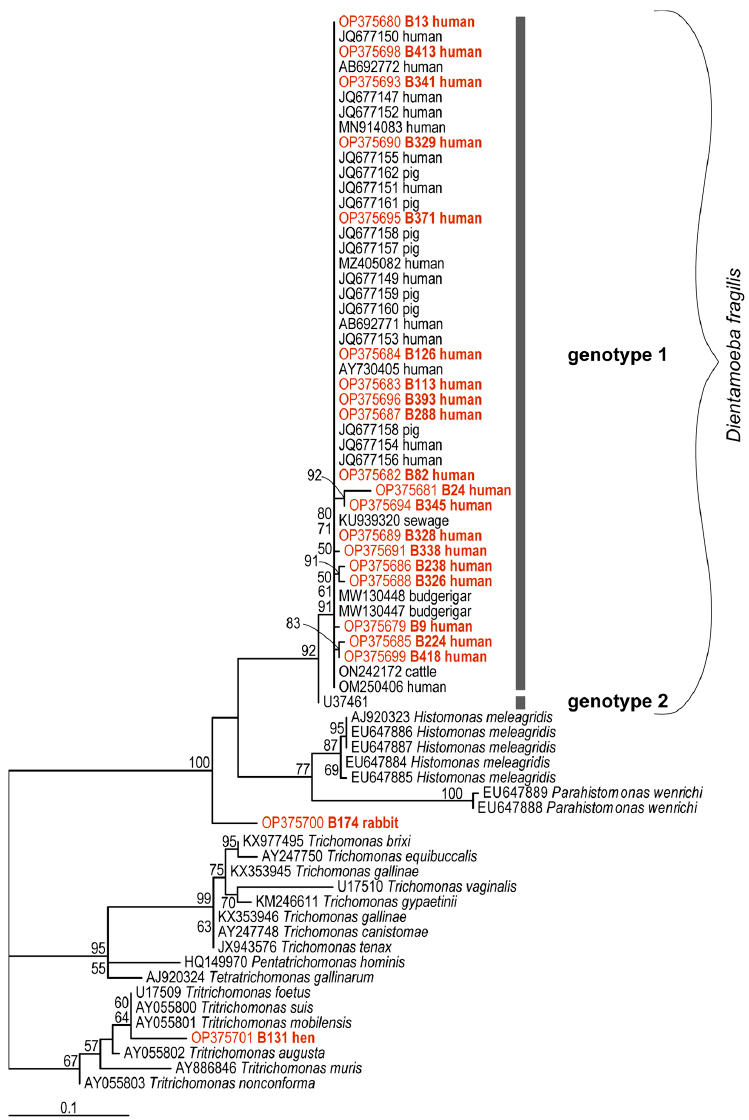
Figure 1. SSU rDNA tree from SSU rDNA sequences of Dientamoeba fragilis computed by IQTree. The numbers of the branches above represent maximum likelihood bootstrap supports as computed from 10,000 UFBoot. The scale bar represents 10 substitutions per 100 positions. New sequences are in red